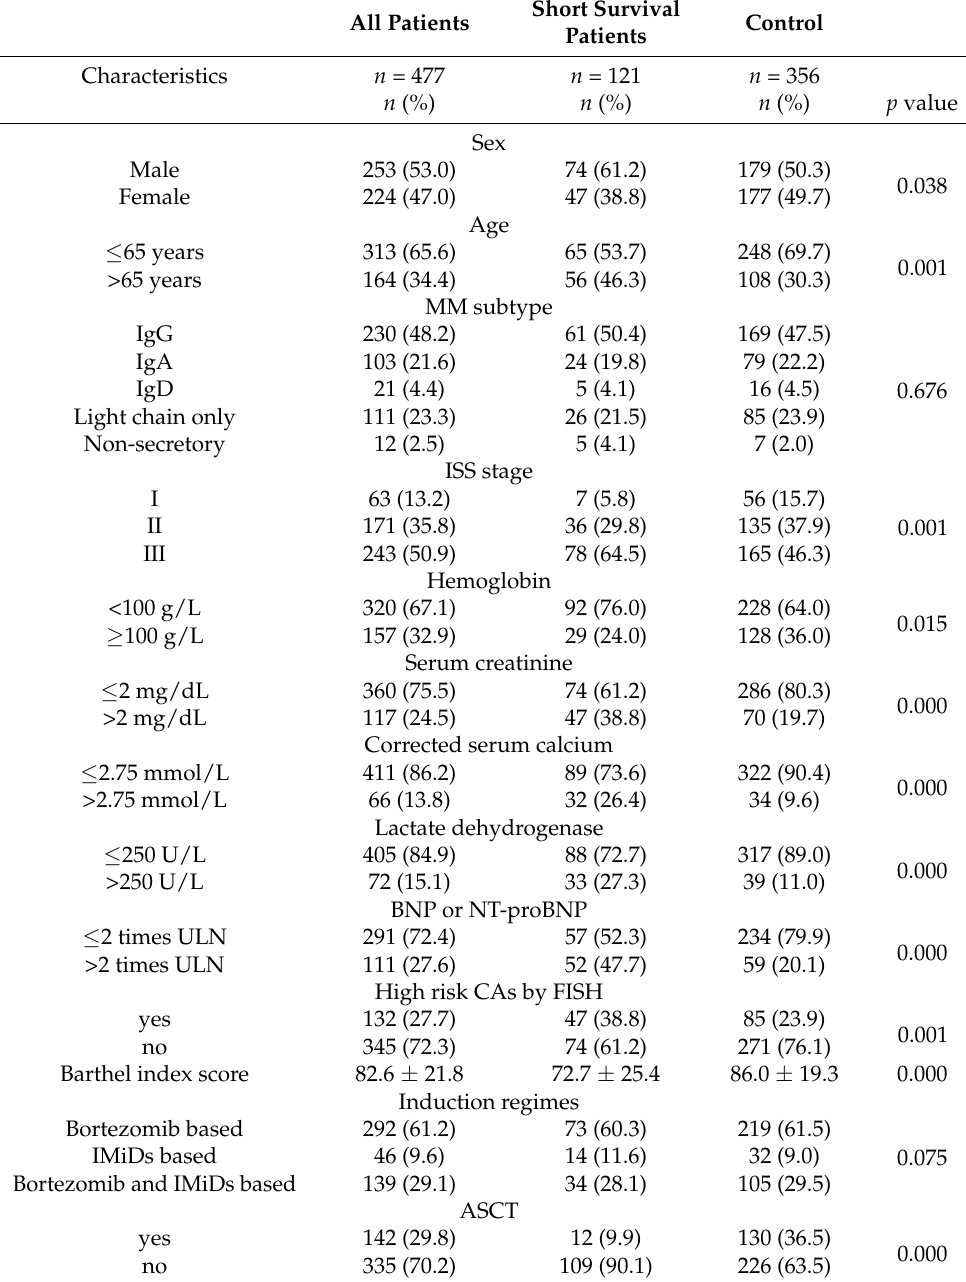
Table 1. Baseline clinical and biological characteristics of MM